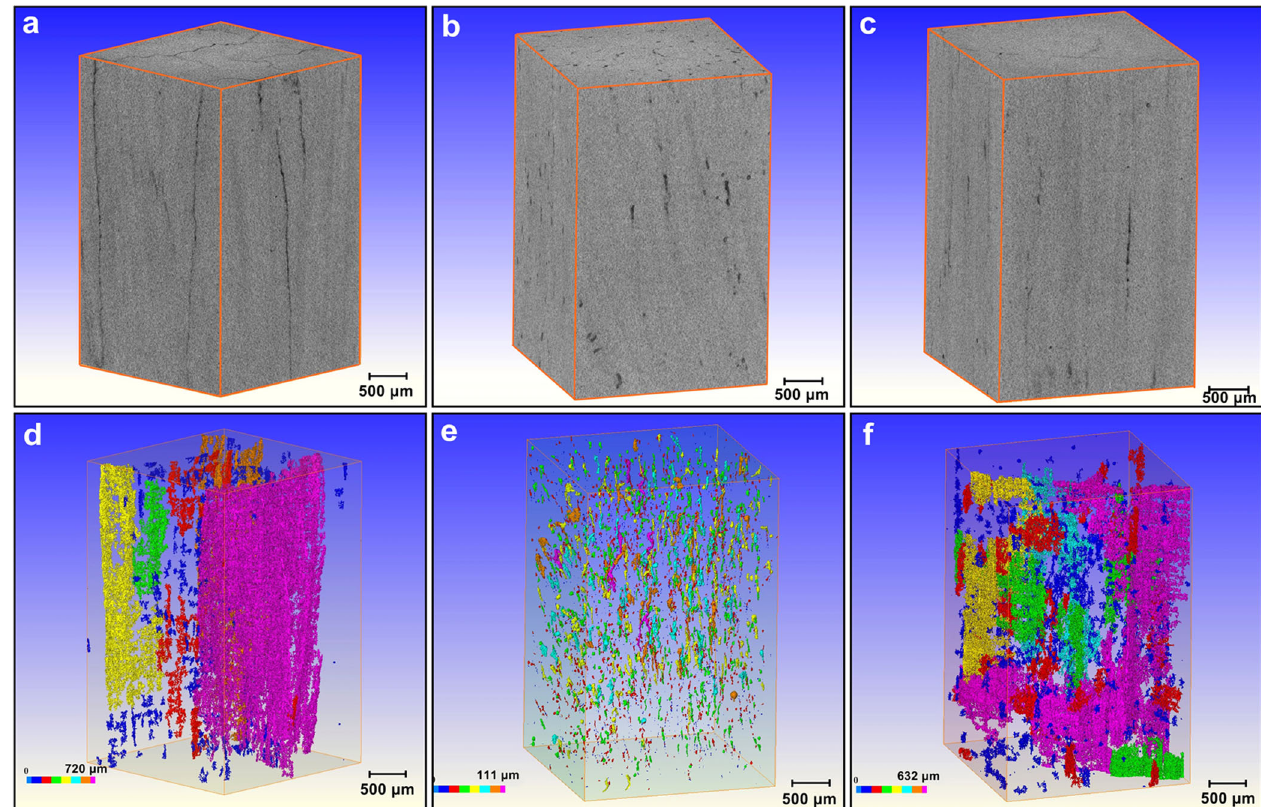
Fig. 2 XRT three-dimensional reconstruction images of different EBM NiTi alloys. a – c Corresponding to the reconstructed morphologies of S1, S5, and S7 respectively, d – f corresponding to defect distribution in the three-dimensional space of S1, S5 and S7